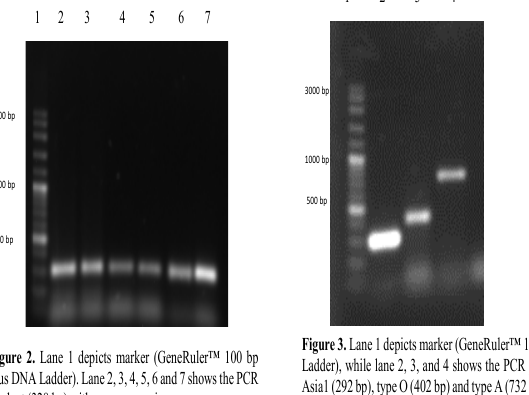
Plus DNA Ladder). Lane 2, 3, 4, 5, 6 and 7 shows the PCR product (328 bp) with consensus primer.